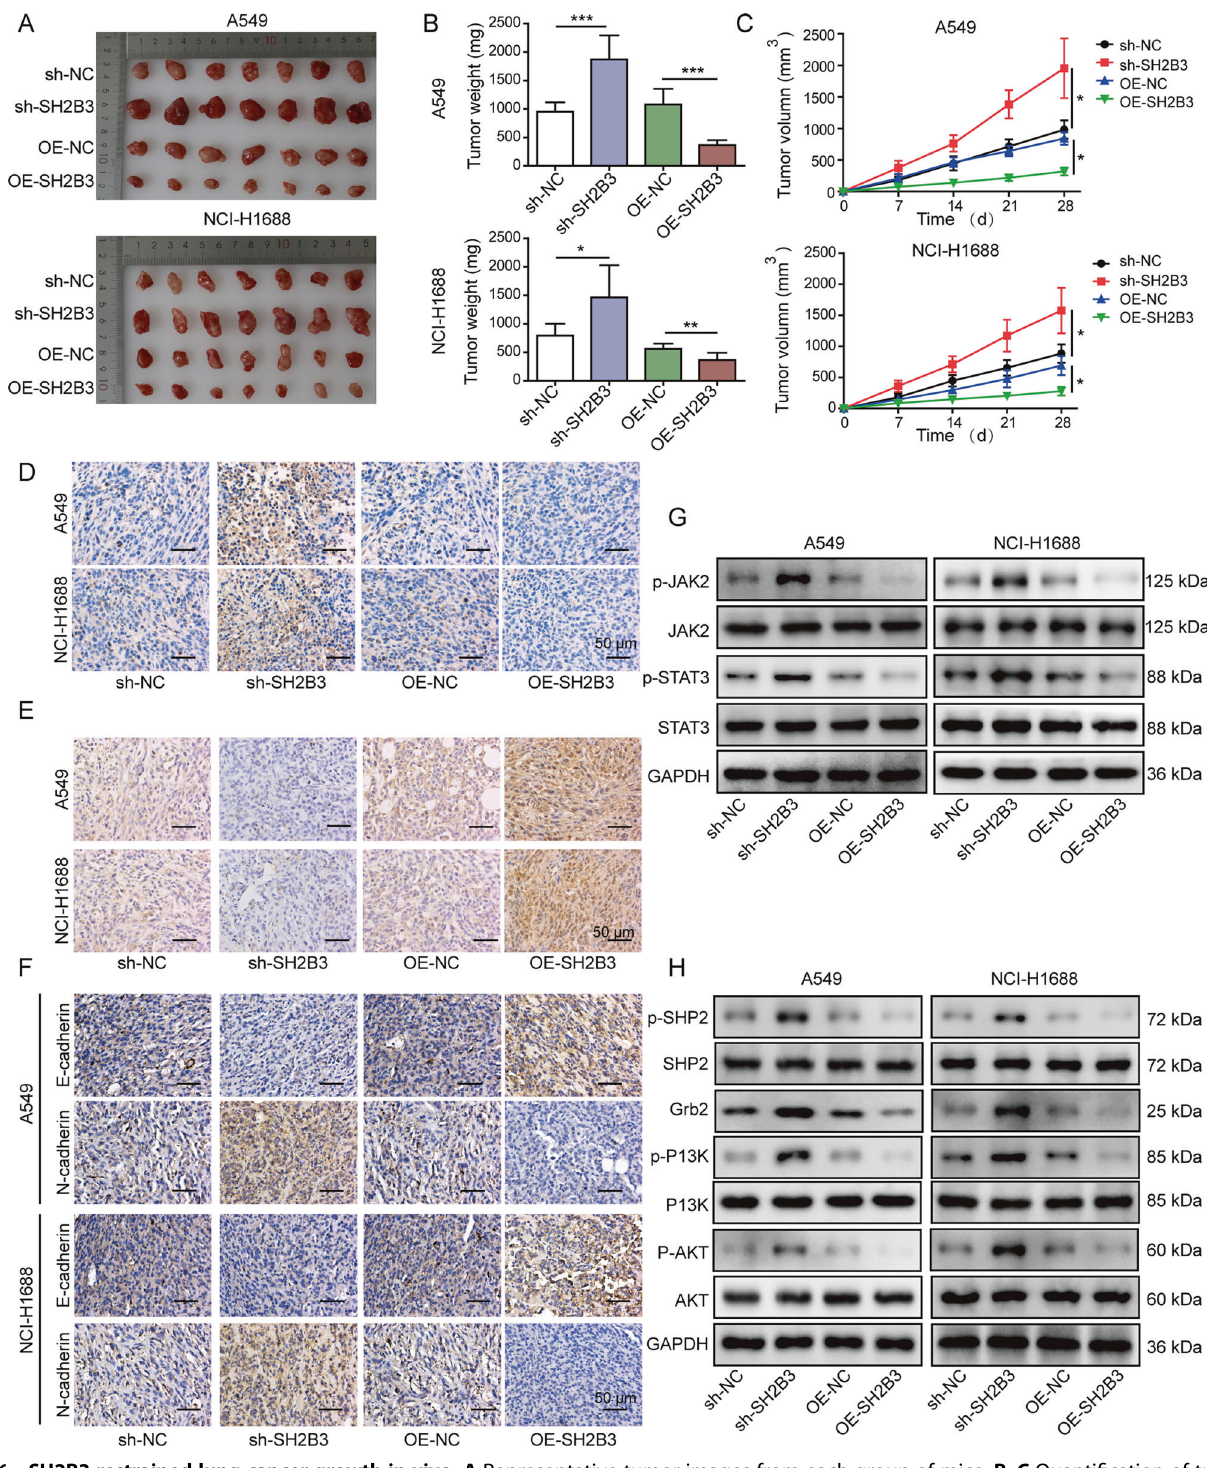
Fig. 6 SH2B3 restrained lung cancer growth in vivo. A Representative tumor images from each group of mice. B , C Quanti fi cation of tumor weight ( B ) and size ( C ) in each group of mice after 28 days of implantation. D IHC to examine Ki-67 level in tumor samples from each group of mice. E IHC to test SH2B3 level in tumor samples from each group of mice. F IHC to evaluate N-cadherin and E-cadherin expression levels in tumor samples from each group of mice. G Western blotting to determine p-JAK2, JAK2, p-STAT3, and STAT3 in tumor samples from each group of mice. H Western blotting to determine p-SHP2, SHP2, Grb2, p-PI3K, PI3K, p-AKT, and AKT in tumor samples from each group of mice. *** P < 0.001, ** P < 0.01, and * P < 0.05.